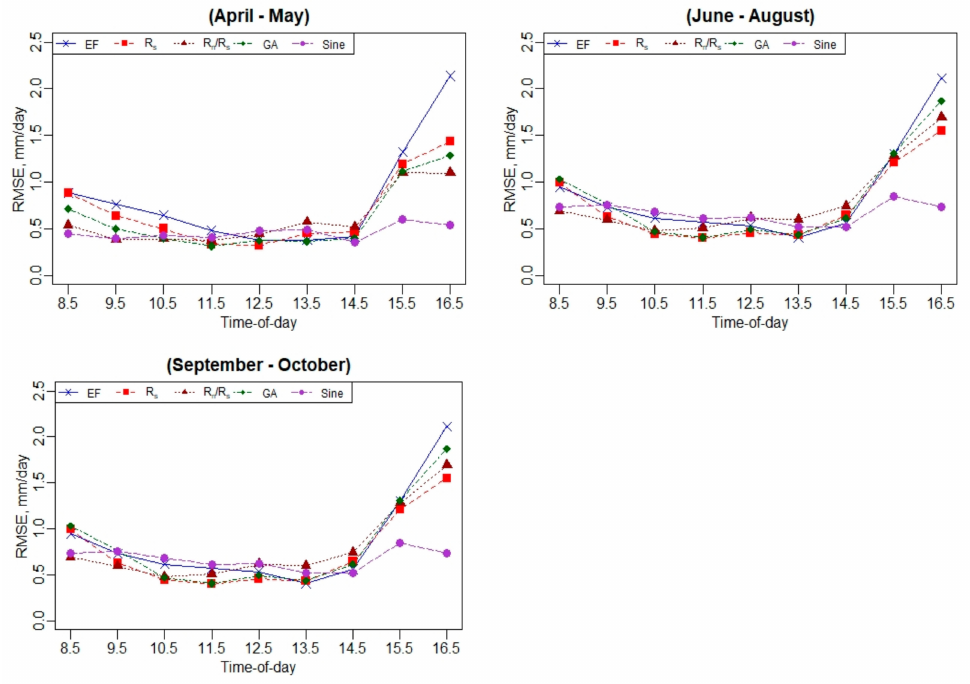
Figure A18. Daily RMSE performance using hourly EC ET